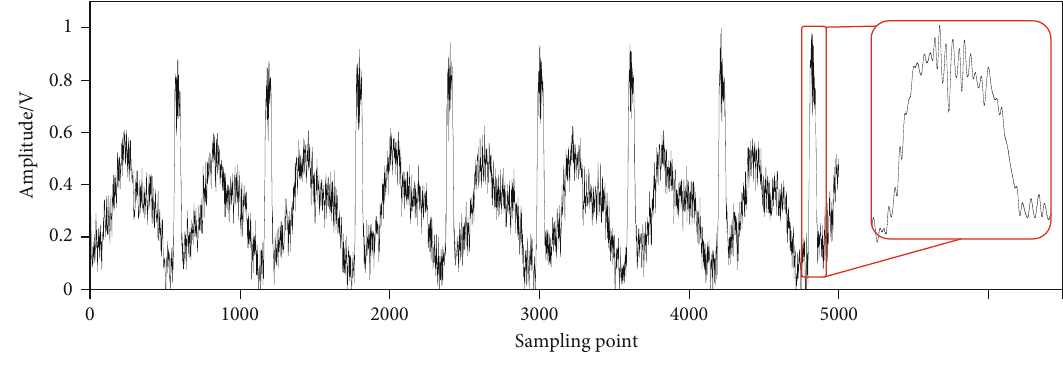
Figure 5: Blade tip timing signal.